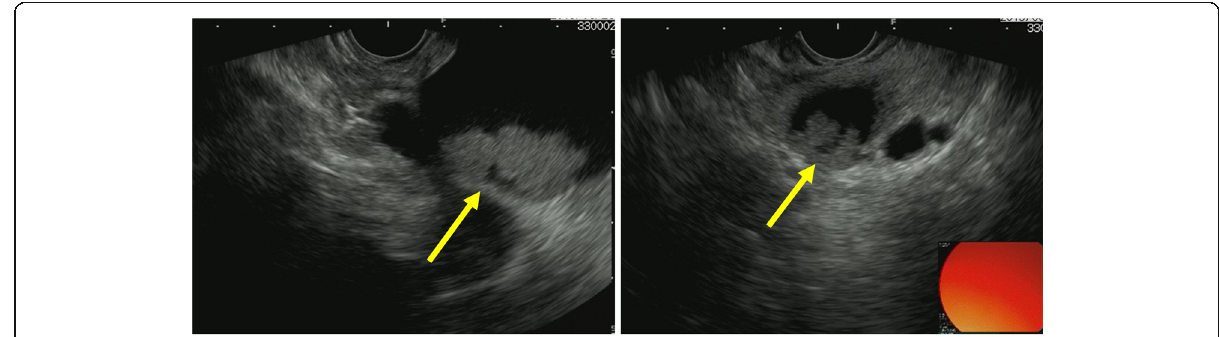
Fig. 2 Endoscopic ultrasonography (EUS) imaging findings. EUS revealed that the cystic tumor of the pancreatic head was a 35-mm solitary cyst with a 24-mm mural nodule, and the cystic tumor of the pancreatic tail was a 20-mm solitary cyst with a mural